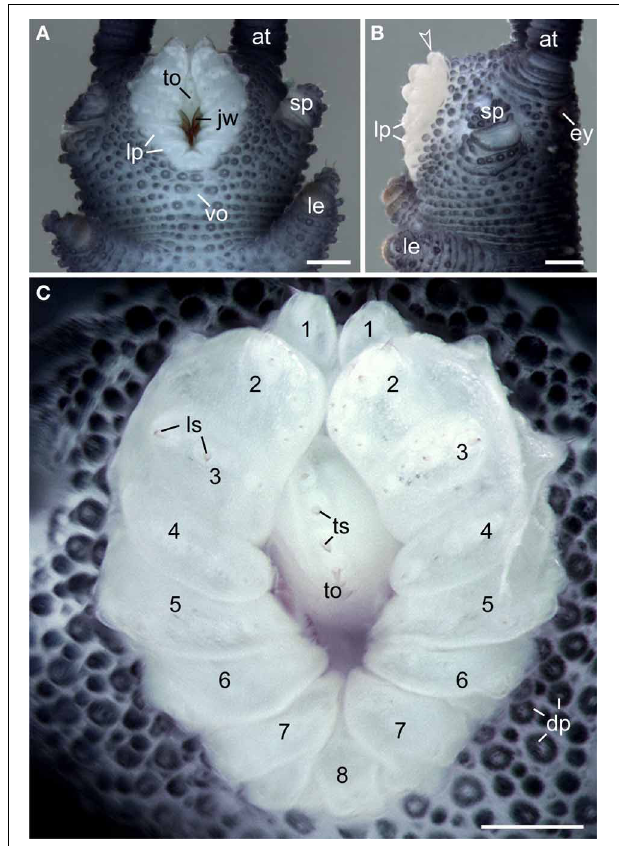
FIGURE 3 | Structure and position of the adult mouth in the onychophoran Euperipatoides rowelli . Stereomicrographs; anterior is up in all images. (A) Head in ventral view. (B) Head in lateral view. Arrowhead points to the anterior-most pair of lip papillae. (C) Detail of lip papillae (numbered). Note that the mouth opening is encompassed by seven paired papillae (no. 1–7) und one unpaired posterior lip papilla (no. 8). Abbreviations: at, antenna; ey, eye; dp, dermal papillae; jw, jaw; le, first walking leg; lp, lip papillae; ls, lip sensilla; sp, slime papilla; to, tongue; ts, tongue sensilla; vo, ventral organ. Scale bars: 250 μ m (A–C)